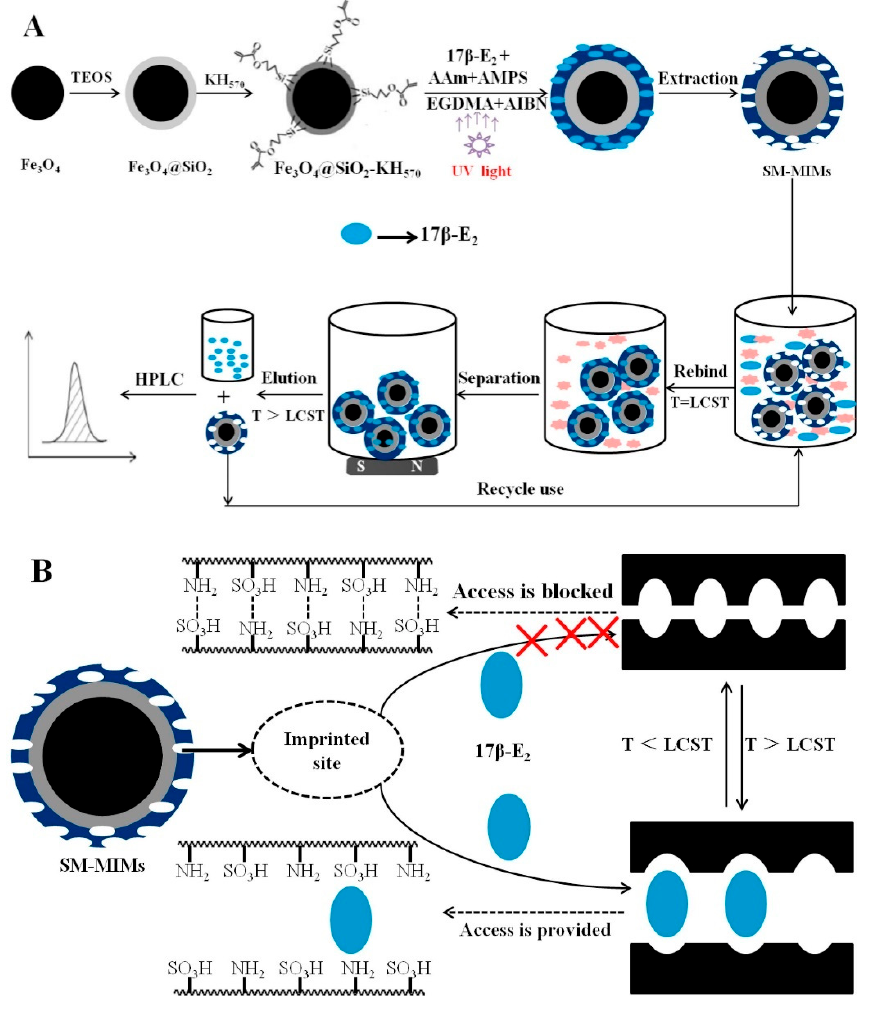
Figure 6. Zipper-like on/off switchable magnetic molecularly imprinted microspheres used by Zhu and colleagues [104] for the solid-phase extraction of steroid hormones in milk samples. ( A ) Repre- sent the preparation of molecularly imprinted microspheres and ( B ) on/off-switchable recognition mechanisms of molecularly imprinted microspheres.